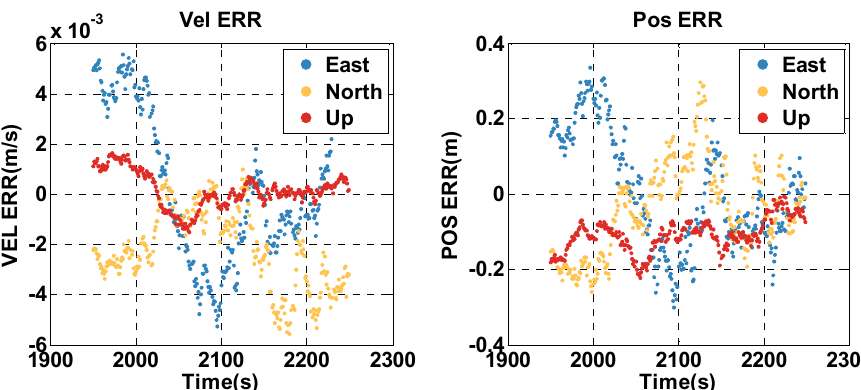
Figure 7. The position and velocity errors of the MTF method in the insufficient satellite case.